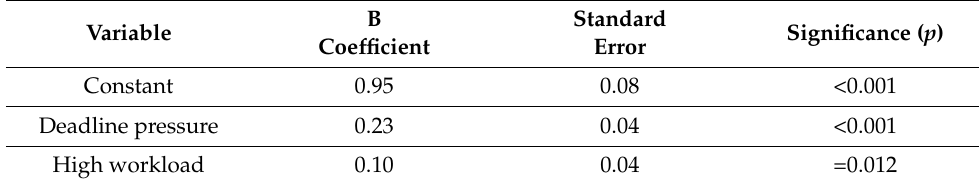
Table 9. Backward selection type of multiple logistic regression for burnout contributing factors.